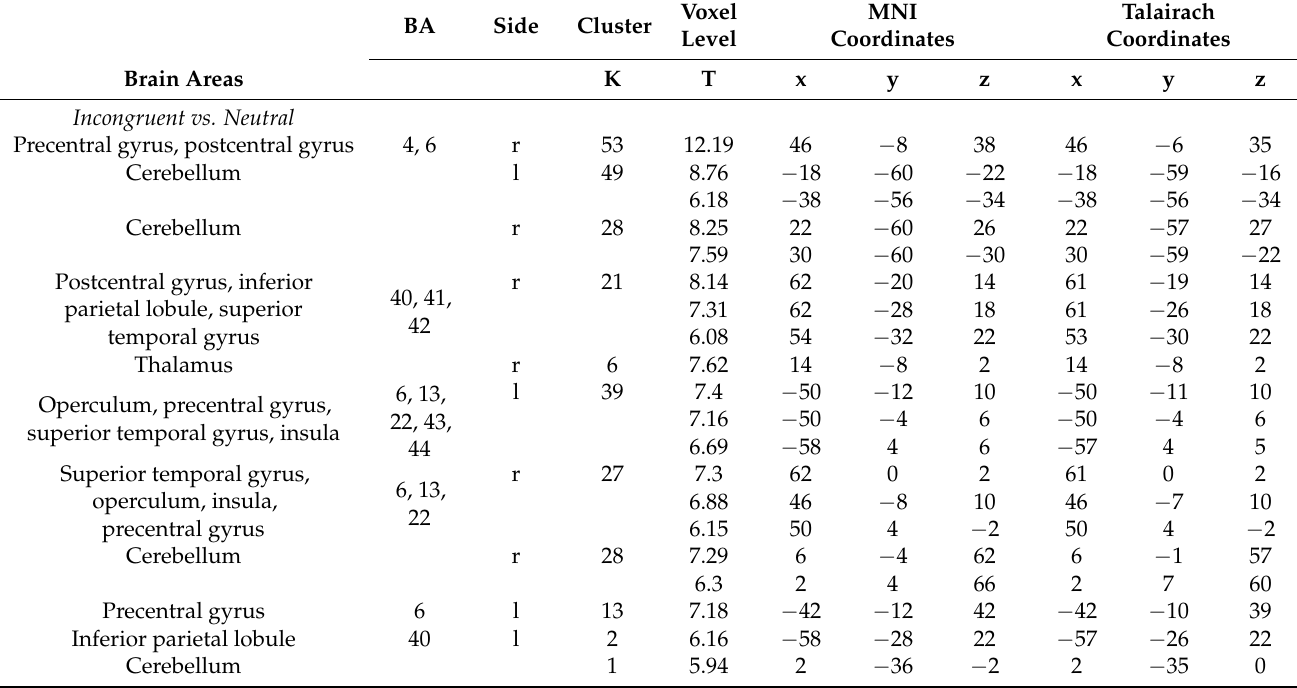
Table 1. Peak coordinates of functional activation related to incongruent conditions.